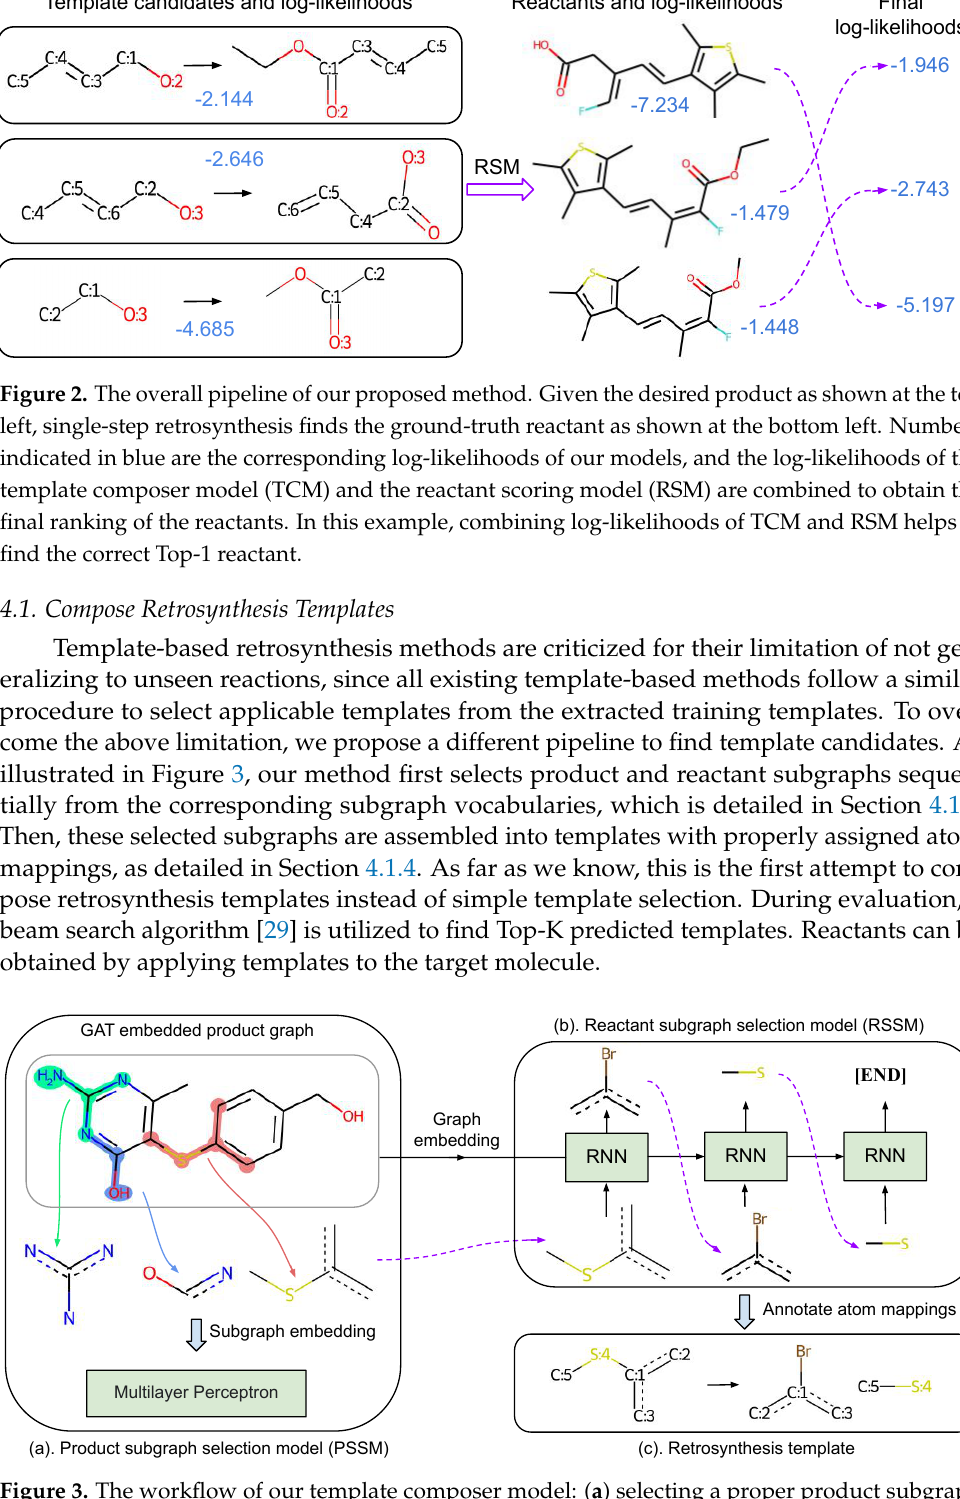
Figure 3. The workflow of our template composer model: ( a ) selecting a proper product subgraph from product subgraph candidates with PSSM, ( b ) selecting reactant subgraphs sequentially from reactant subgraph vocabulary with RSSM, and ( c ) annotating atom mappings between the product and reactant subgraphs to obtain a